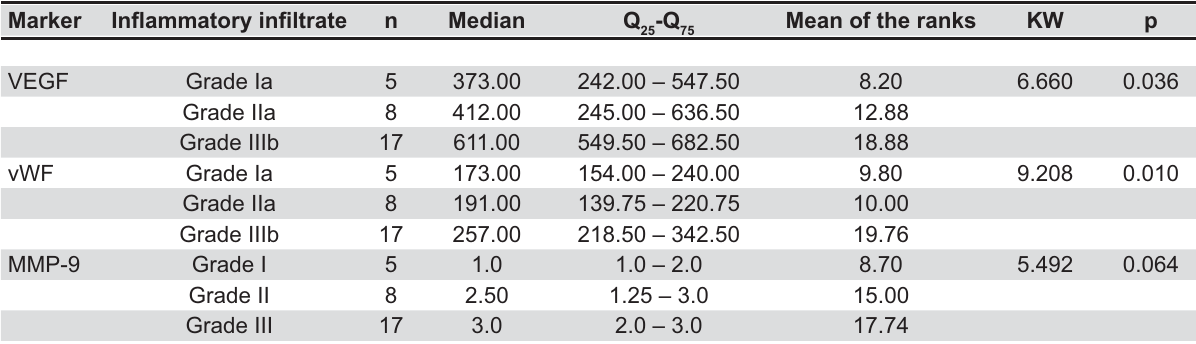
Table 2- Parameters used for the calculation of the Kruskal-Wallis (KW) test for the evaluation of the expression of vascular endothelial growth factor (VEGF), von Willebrand factor (vWF), and matrix metalloproteinase-9 (MMP-9) according to the